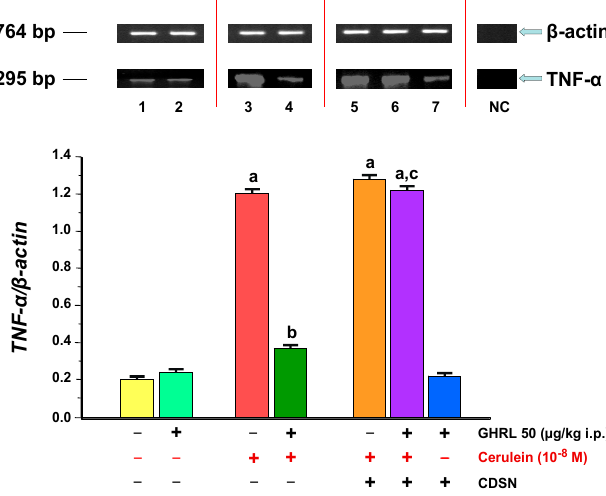
Analysis of tumor necrosis factor- α ( TNF- α ) gene expression assessed using reverse transcription-polymerase chain reaction (RT-PCR) and densitometric analysis of TNF- α / β -actin mRNA ratio in isolated pancreatic acinar cells: (lane 1) acinar cells obtained from control sensory nerves (SN)-intact rats treated with saline, after isolation, acinar cells incubated in cerulein-free solution; (lane 2) acinar cells obtained from SN-intact rats treated with ghrelin (GHRL), after isolation, acinar cells incubated in cerulein-free solution; (lane 3) acinar cells obtained from SN-intact rats treated with saline, after isolation, acinar cells incubated in solution containing cerulein at a concentration of 10 − 8 M; (lane 4) acinar cells obtained from SN-intact rats treated with GHRL, after isolation, acinar cells incubated in solution containing cerulein at a concentration of 10 − 8 M; (lane 5) acinar cells obtained from rats with capsaicin deactivation of SN (CDSN) and treated with saline, after isolation, acinar cells incubated in solution containing cerulein at a concentration of 10 − 8 M; (lane 6) acinar cells obtained from rats with CDSN and treated with GHRL, after isolation, acinar cells incubated in solution containing cerulein at a concentration of 10 − 8 M; (lane 7) acinar cells obtained from rats with CDSN and treated with GHRL, after isolation, acinar cells incubated in cerulein-free solution. NC = negative control. Reference gene: β -actin . a p < 0.05 compared to control acinar cells obtained from rats with intact SN (lane 1); b p < 0.05 compared to acinar cells stimulated with cerulein after isolation from SN-intact rats treated with saline (line 3); c p < 0.05 compared to acinar cells stimulated with cerulein after isolation from SN-intact rats treated with GHRL (lane 4). In each experimental group, there was at least six observations.